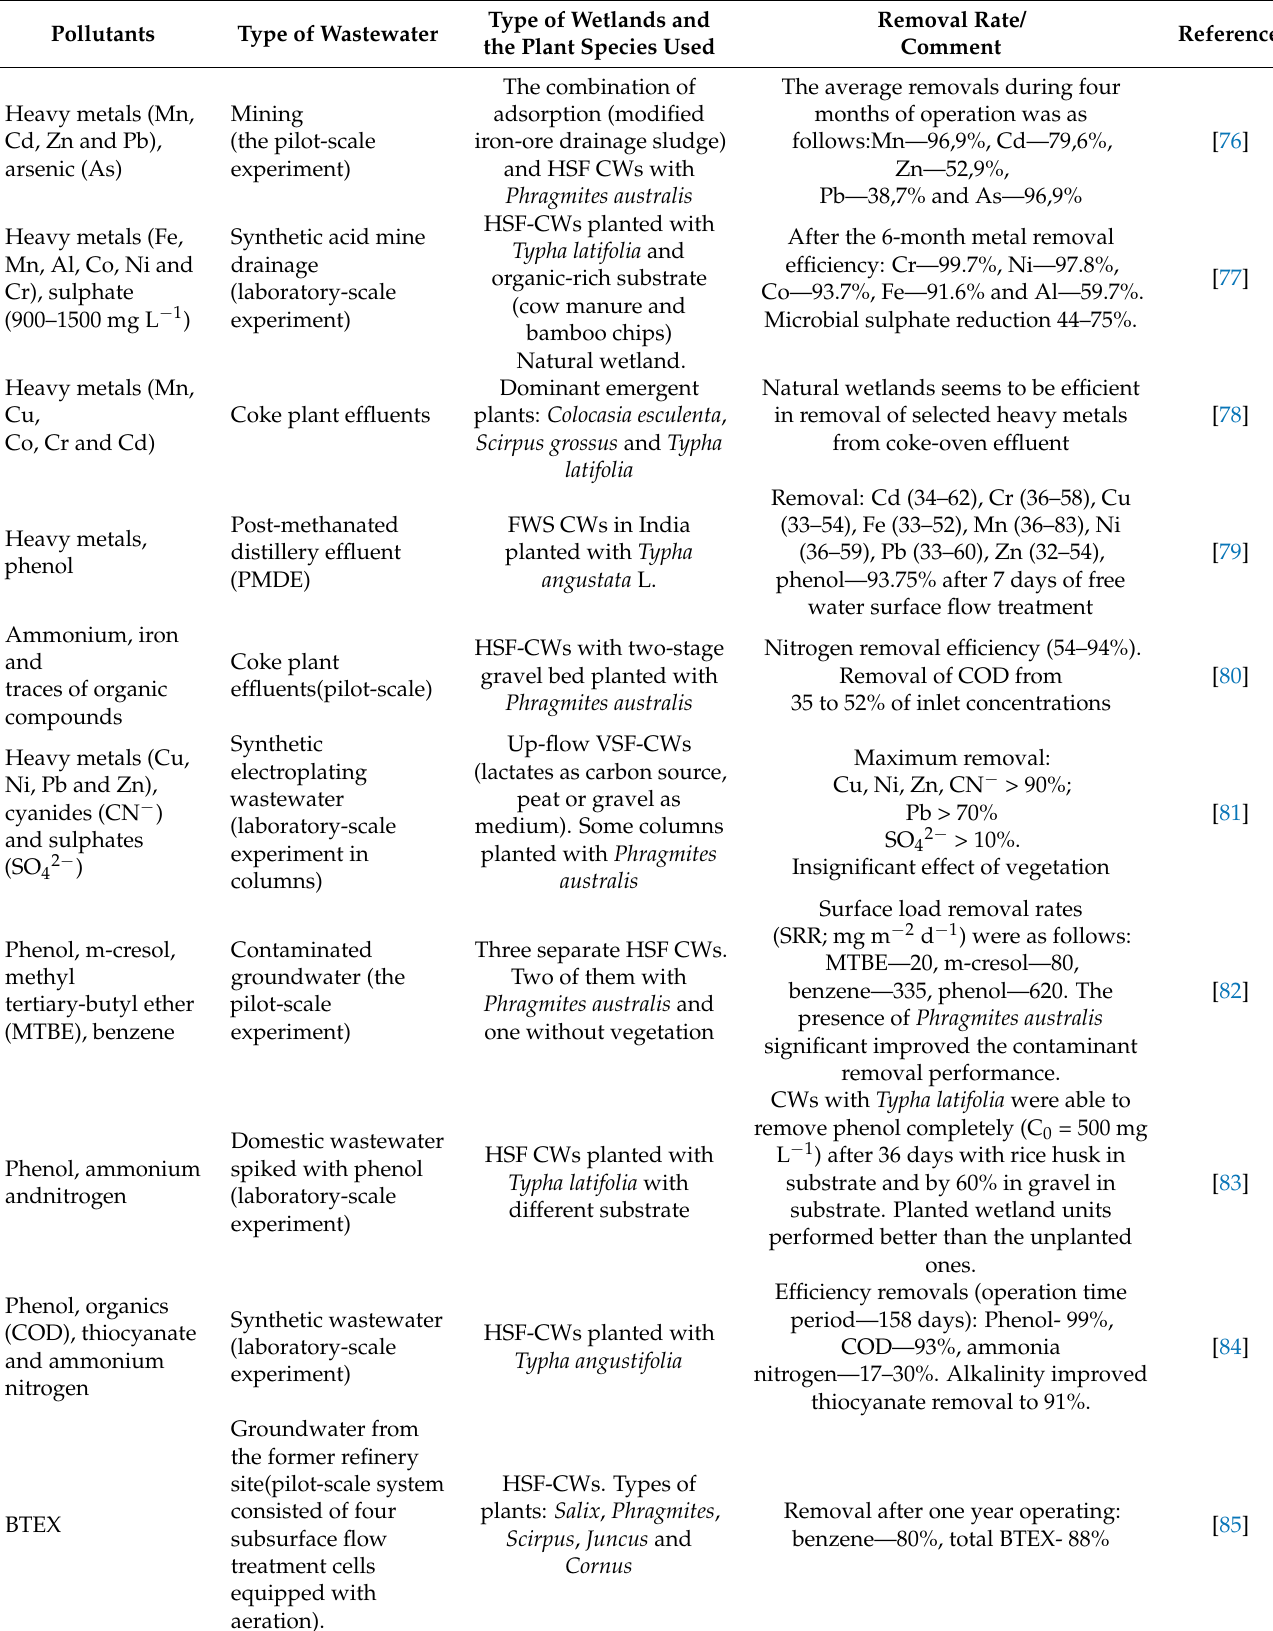
Table 5. Examples of the experiments described in the literature using wetlands as a bioremediation